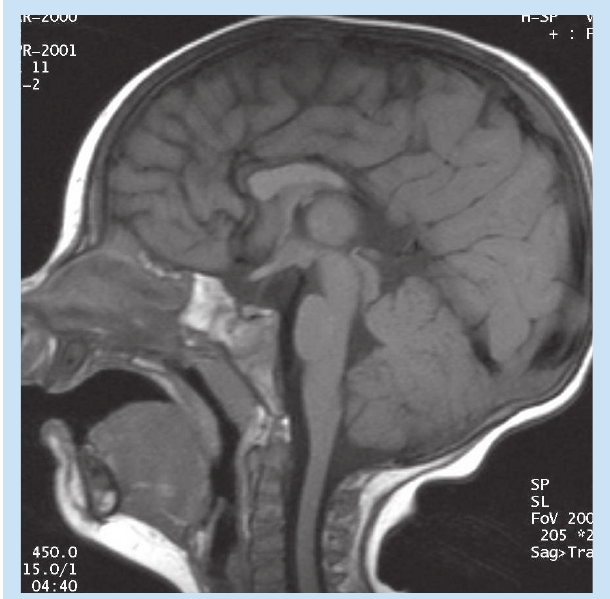
Fig. 1. Incomplete formation (hypogenesis) of the corpus callosum.